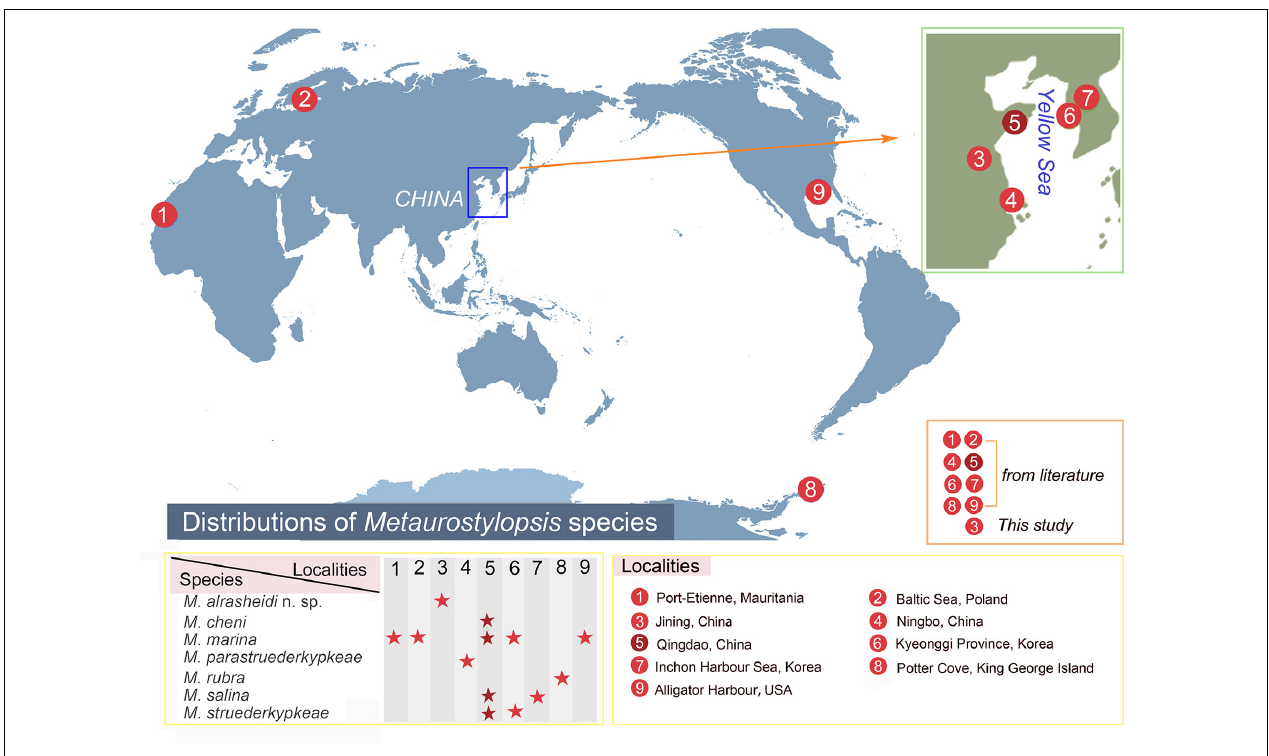
FIGURE 8 | Distribution of Metaurostylopsis